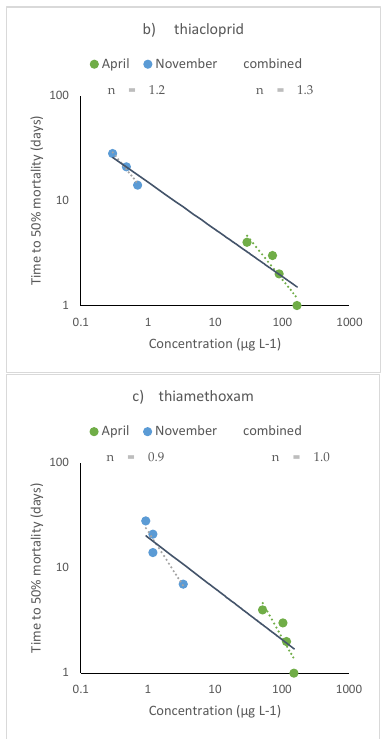
Figure 2. Time-cumulative toxicity of ( a ) imidacloprid, ( b ) thiacloprid and ( c ) thiamethoxam tested on nymphs of the mayfly Cloeon dipterum (after van den Brink et al. 2016 [39]). Tests were carried out separately for acute (up to 4 days) and chronic toxicity (up to 28 days), with individual tests showing values of n ≥1 (dotted lines). The combined sets also show values of n >1 (solid lines), confirming the time-dependent toxicity of all three compounds.